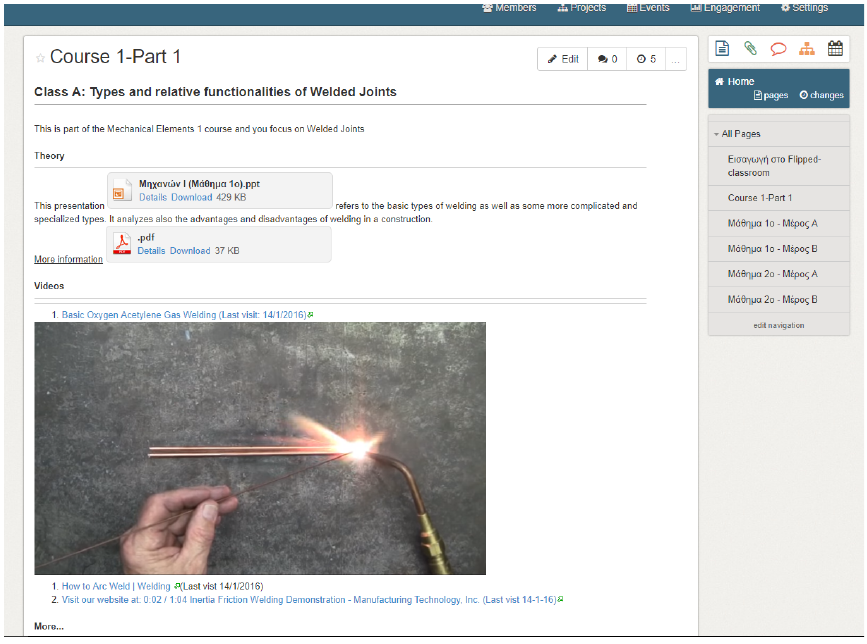
Fig. 1. The wiki environment providing content for the preparation